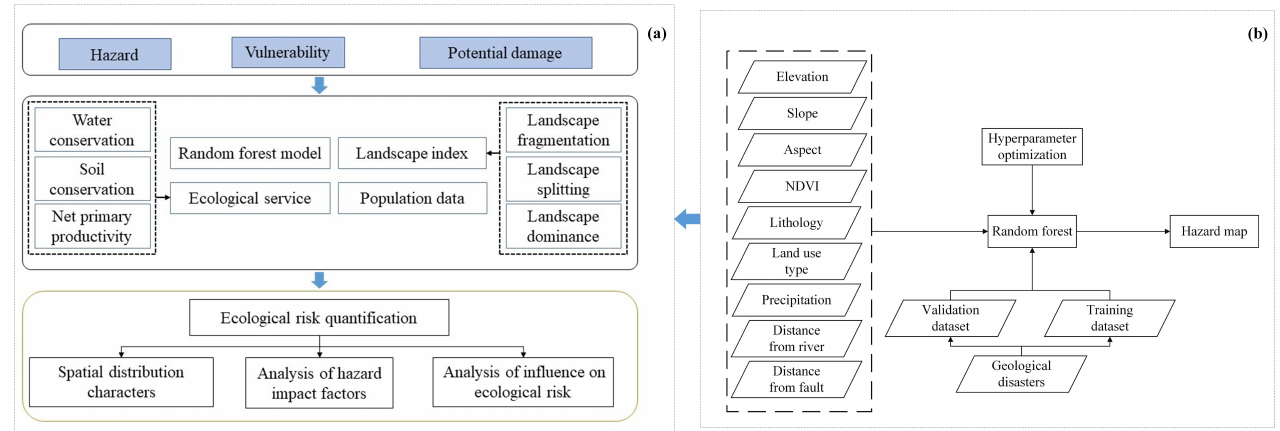
Figure 2. The flowchart of ( a ) ecological risk assessment framework and ( b ) hazard assessment of geological